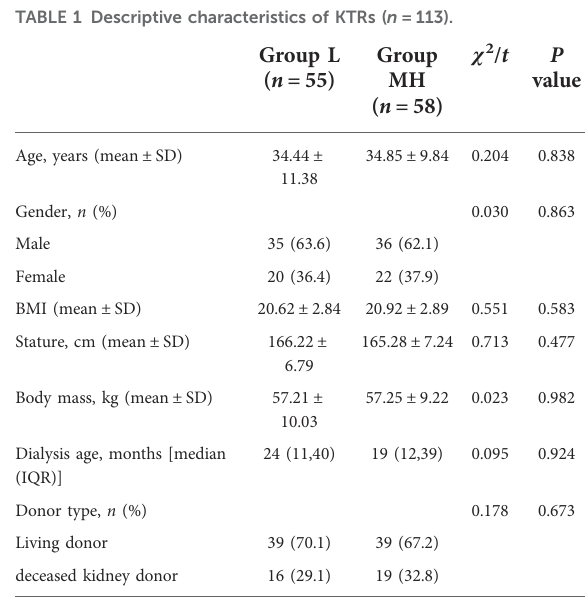
FIGURE 2 Distribution of PA levels among 113 patients.